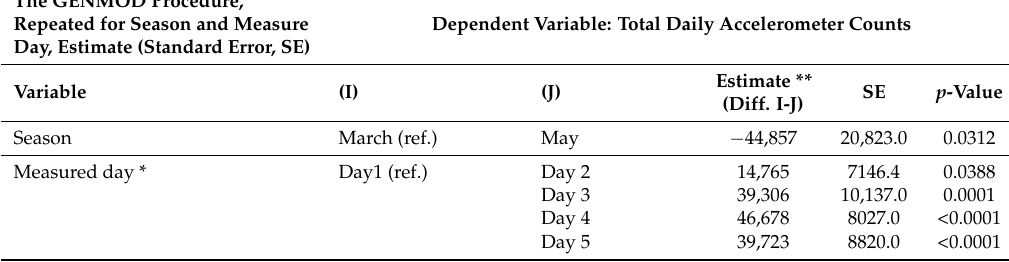
Table 2. Predictors for physical activity during school stay (accelerometer counts), non-significant p -values not